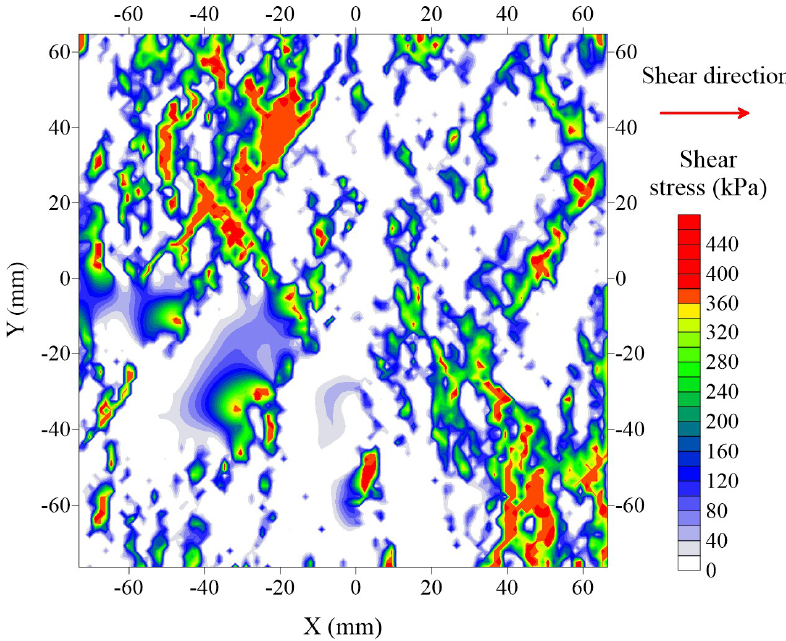
Figure 14. Shear stress distribution for shearing in the positive direction of the x axis.